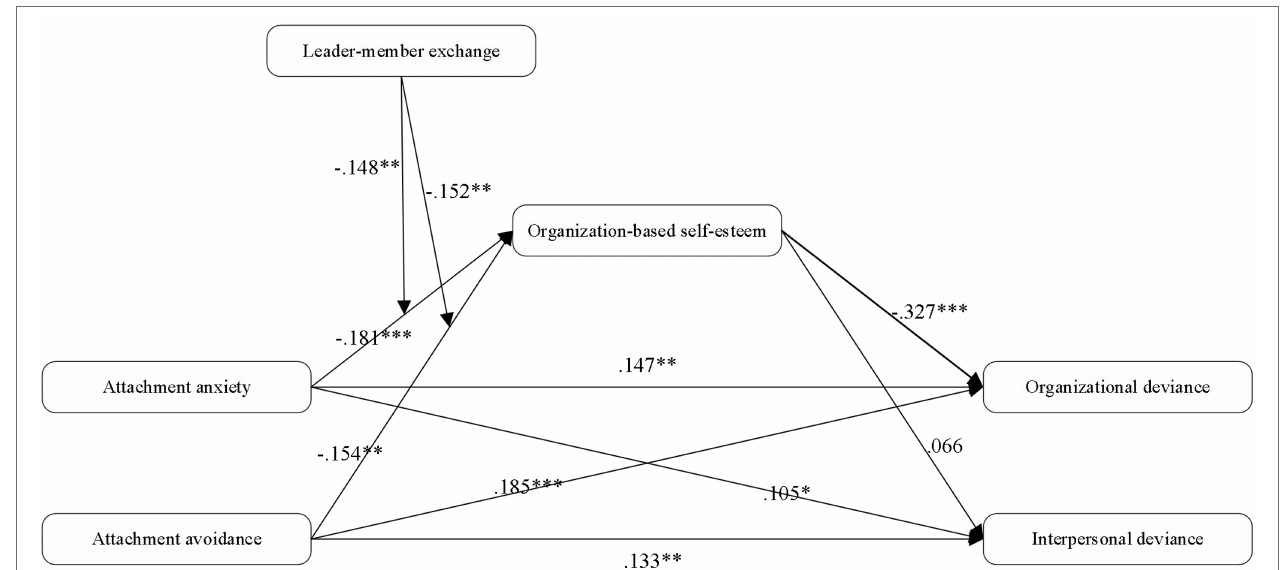
FIGURE 2 | Standardized path coefficients for the direct and indirect effects of insecure attachment style (IAS) upon workplace deviation behavior (WDB) through organization-based self-esteem (OBSE) and moderated by leader–member exchange (LMX; n = 422). Participant age, gender, education, tenure, position, and tenure with supervisor are included as control variables. * p < 0.05; ** p < 0.01; *** p <